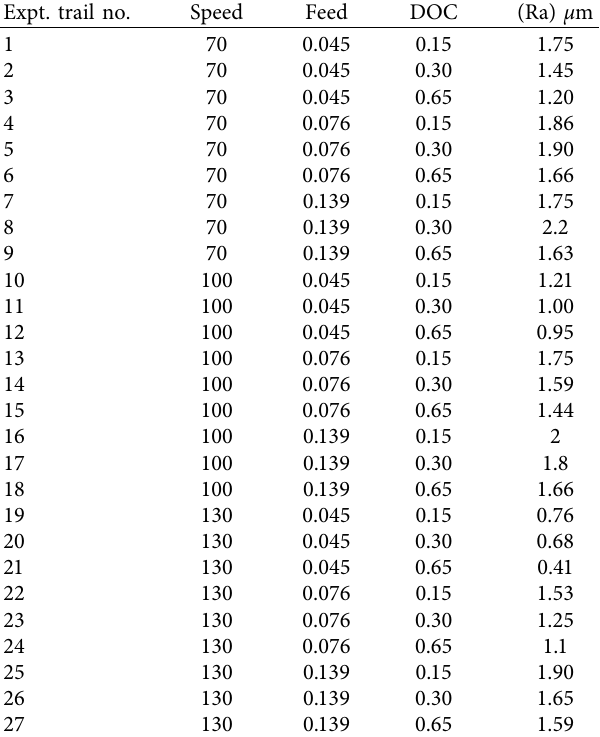
Table 3: Experimental trail results.